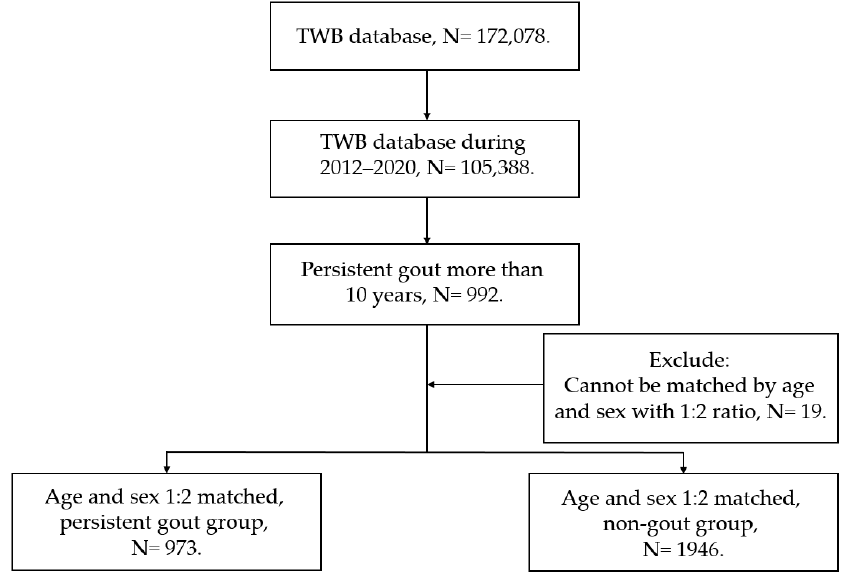
Figure 1. The flowchart of selection process in the current study. TWB: Taiwan Biobank. N: number.